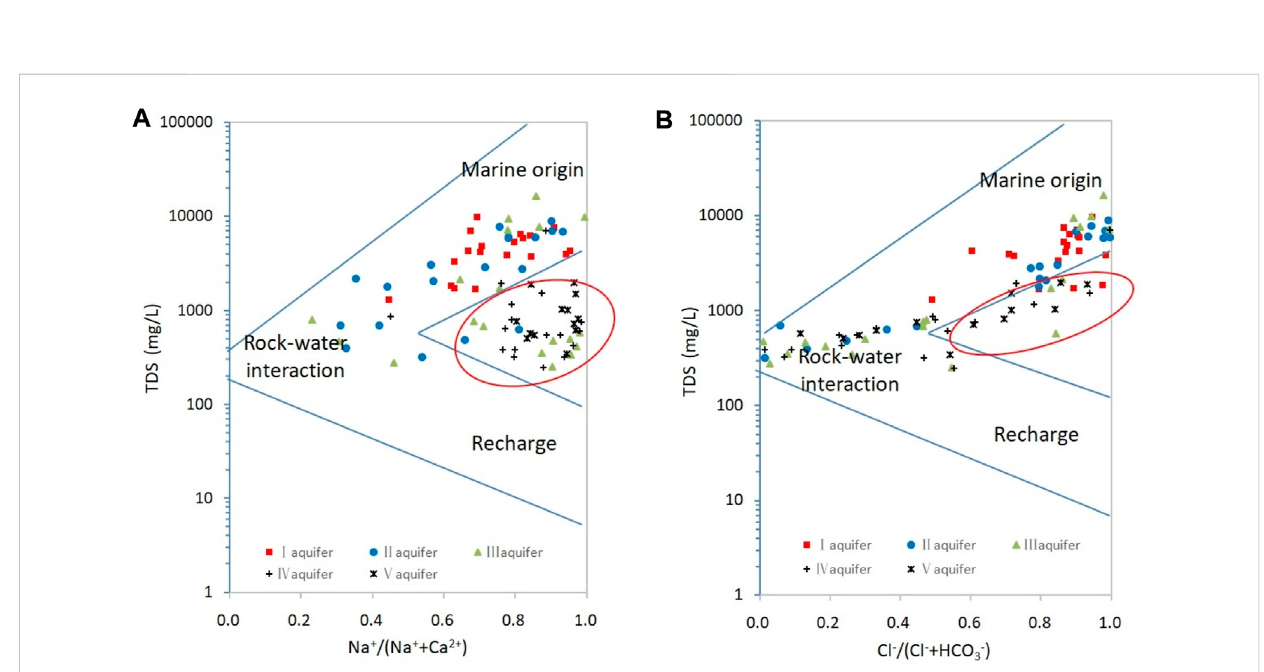
FIGURE 6 Gibbs diagrams for con fi ned groundwater. The red circles indicate samples that deviate from the Gibbs model. (A) Gibbs diagrams of ions. (B) Gibbs diagrams of anions.